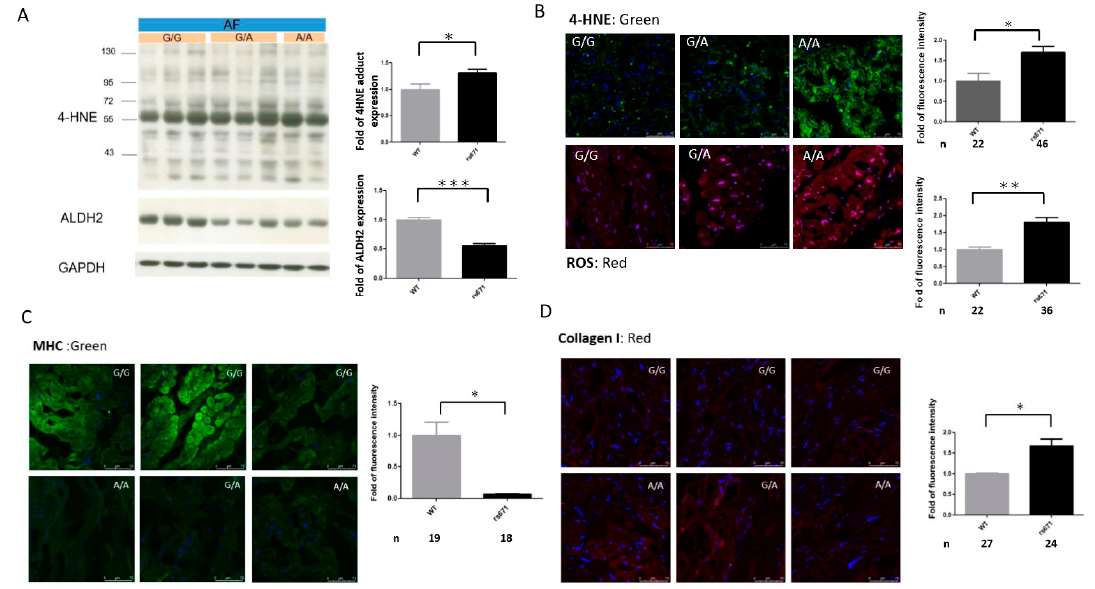
Figure 5. Associations between the ALDH2*2 polymorphism (rs671) and oxidative stress and atrial structural remodeling in human AF tissues. ( A ) Western blot and quantification relative to GAPDH of 4-HNE and ALDH2 expression in the homogenates of atria from AF patients with the indicated rs671 genotypes. Each value represents the mean ± SE of at least three independent experiments. Representative confocal images show 4-HNE ( B ), reactive oxygen species (ROS) (B), myosin heavy chain (MHC) ( C ) and collagen I ( D ) production in the atria of eight AF patients (3 wild-type (WT), 5 rs671 with 3 ALDH2*1*2 and 2 ALDH2*2*2 ). Relative fluorescence density was quantified (right). At least 10 random fields were chosen with scanning and averaging. N, the number of fields observed in each quantitative measurement; data are expressed as mean ± SE. * p < 0.05, ** p < 0.01, *** p < 0.001.